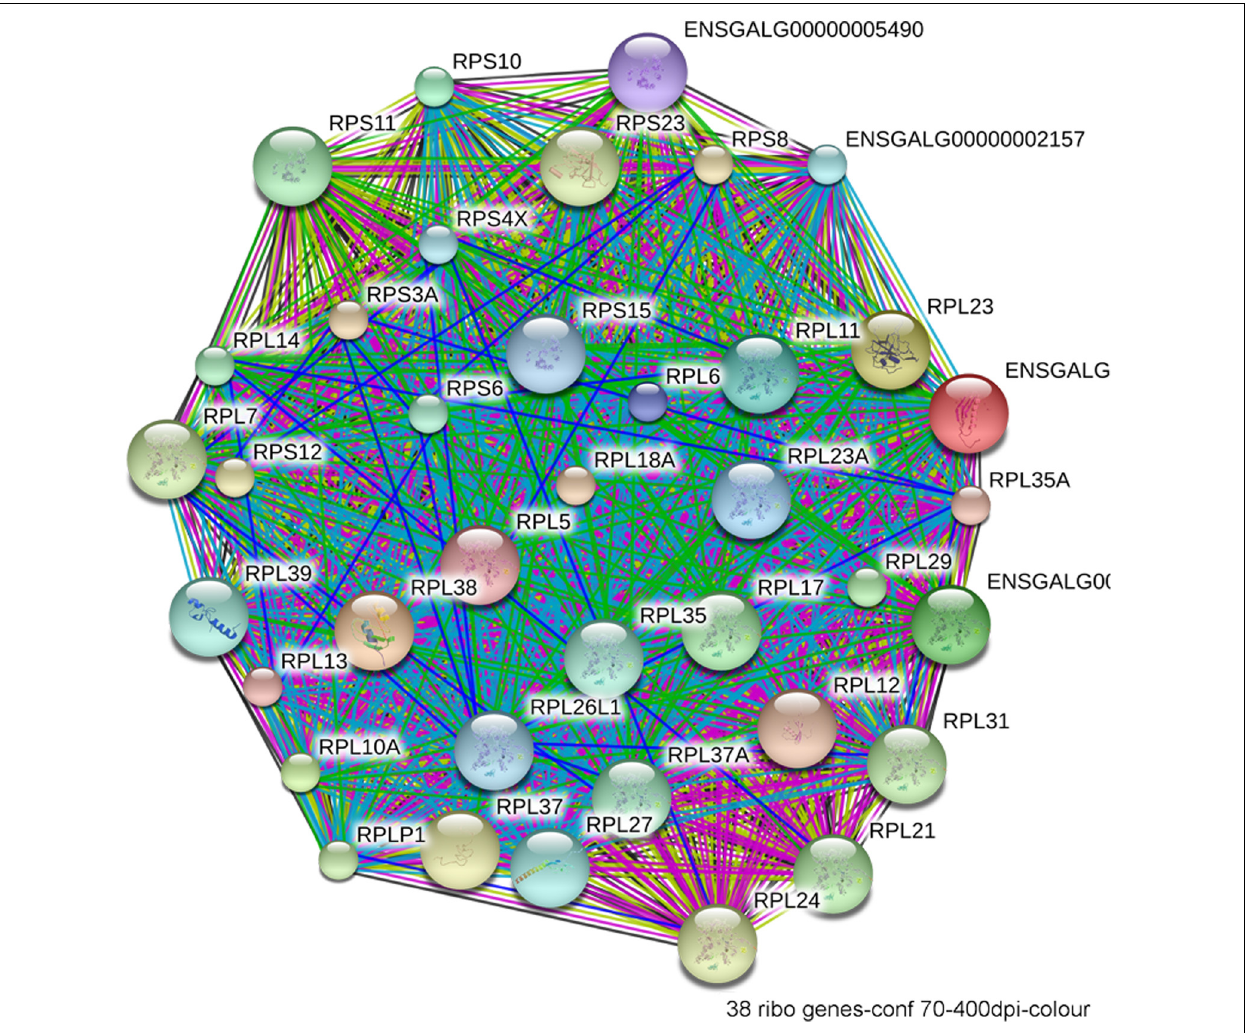
FIGURE 5 | Network interactions from the Database forAnnotation,Visualization, and Integrated Discovery (DAVID) depict the relationships between the 38 ribosomal proteins that have significantly different expression between ethanol-sensitiveW98S and ethanol-resistantW98D neural folds.